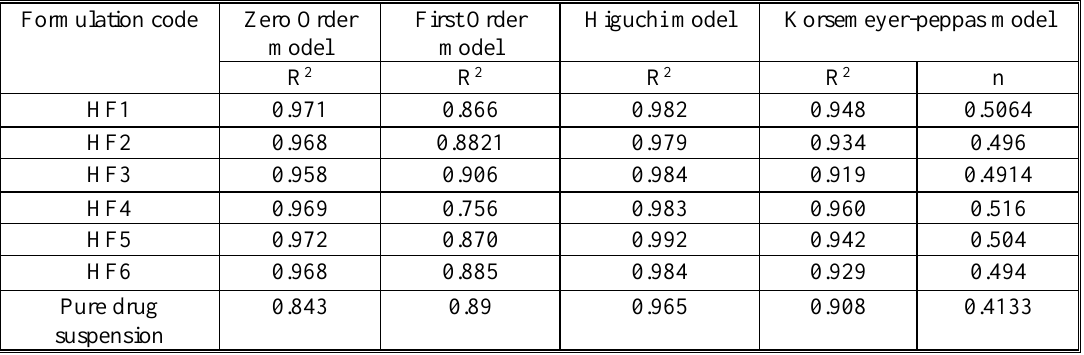
Table 3. The correlation coefficient (R2) and release exponent (n) of different kinetic models of felodipine